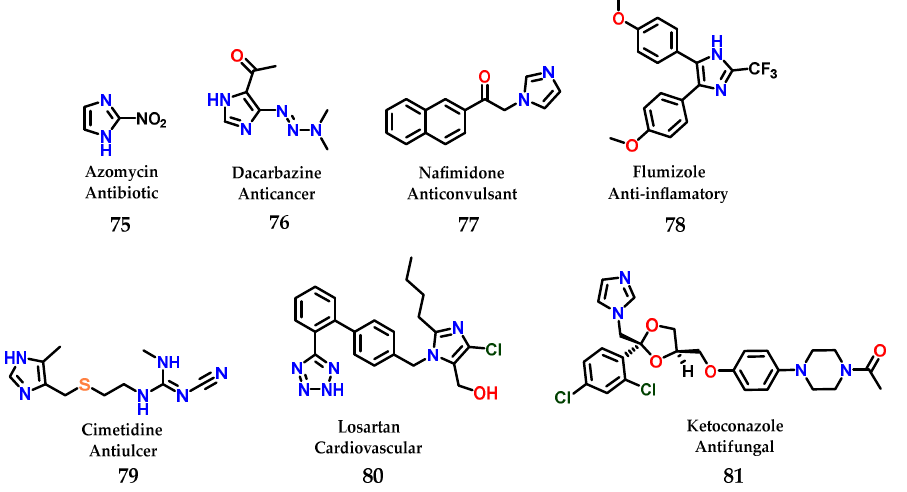
Figure 32. Structures of azomycin 75 and other imidazole-containing drugs currently used in phar- macotherapy.